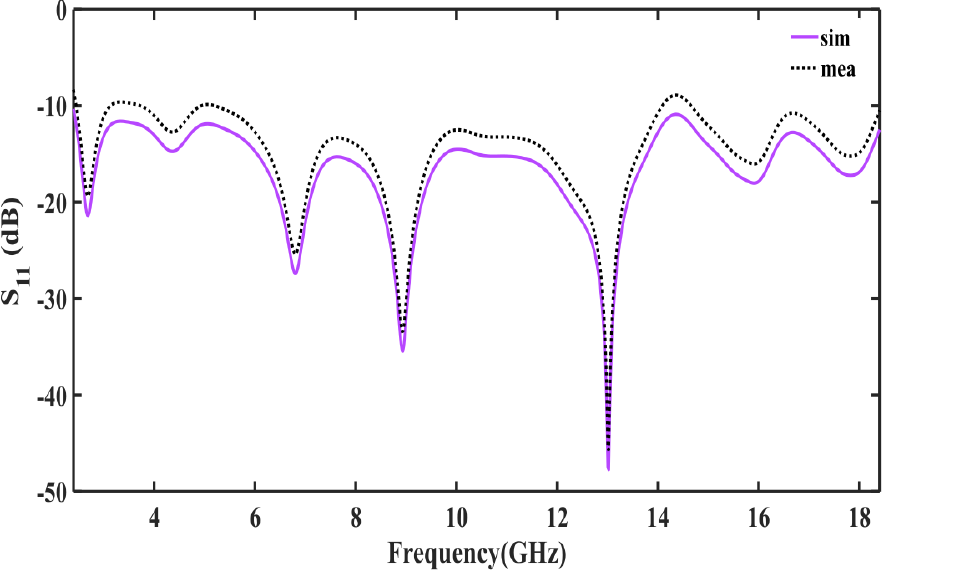
Figure 13. Measured and simulated S 11 of the proposed